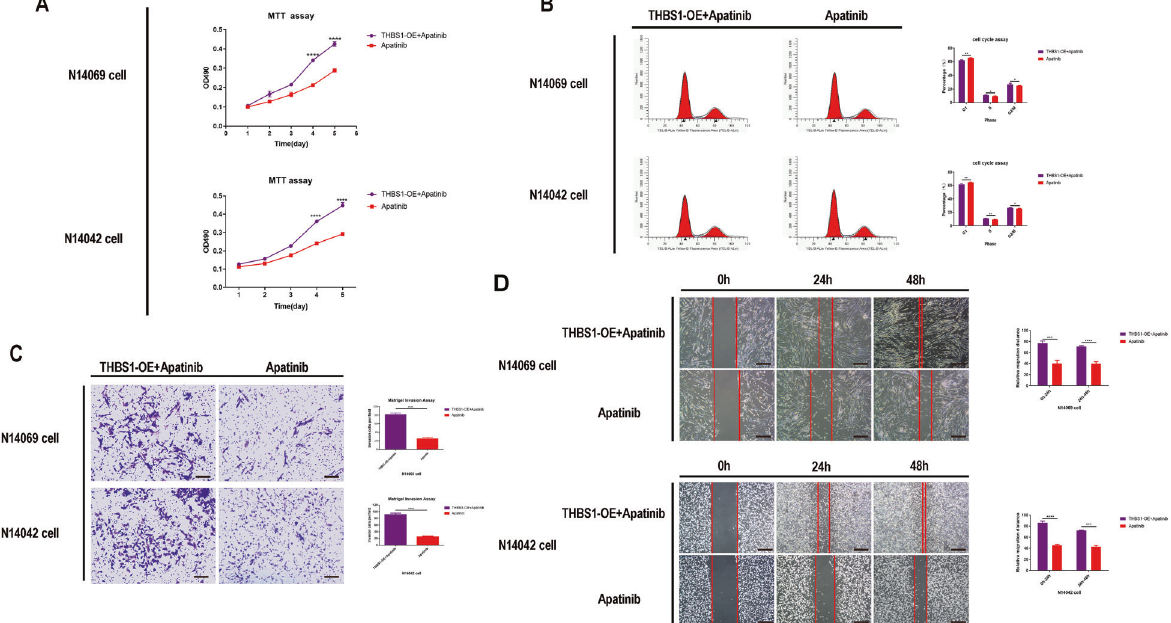
Fig. 5 Thrombospondin 1 overexpression (THBS1-OE) can counteract the inhibitory effect of apatinib on glioma cell proliferation, migration, and invasion. A Representative proliferation curves showed that glioma cell proliferation was signi fi cantly inhibited upon apatinib treatment (at IC 50 ) compared with the THBS1-OE plus apatinib treatment group. B Representative fl ow cytometry pro fi les and corresponding histograms showed that apatinib treatment compared with THBS1-OE plus apatinib treatment led to cell cycle arrest of glioma cells (at IC 50 ). Representative images and corresponding histograms of C Transwell migration (×100 magni fi cation) and D scratch assay results (×40 magni fi cation) showing the migration and invasion of glioma cells, respectively. Compared with THBS1-OE plus apatinib-treated cells, apatinib-treated cells inhibited the migration and invasion of glioma cells (apatinib concentration is within 5% of the lethal dose). Data are shown as mean ± standard deviation (SD), n = 3, * p < 0.05, ** p < 0.01, *** p < 0.001, **** p < 0.0001, Student ’ s t test. Cell Death and Disease (2021)